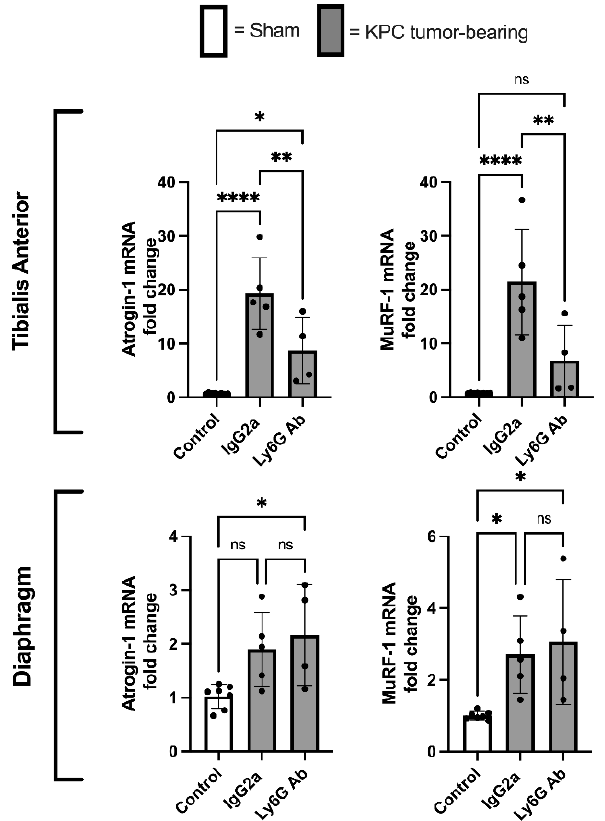
Figure 7. The depletion of Ly6G+ cells inhibits the KPC-induced upregulation of the muscle-specific E3 ligases, atrogin1/Fbxo32 and MuRF1/Trim63 . RT-qPCR-based measurement of atrogin-1 /Fbxo32 and MuRF1 /Trim63 mRNA in TA and diaphragm muscles of Sham mice ( n = 8), and KPC treated with either isotype control (IgG2a; n = 5) or anti-Ly6G antibody ( n = 4). Gene expression data are normalized to GAPDH as a reference gene. PCR reactions were run in triplicate and the average Ct value was used for analysis. * p < 0.05; ** p < 0.01; **** p < 0.0001; ns = not significant ( p > 0.05).